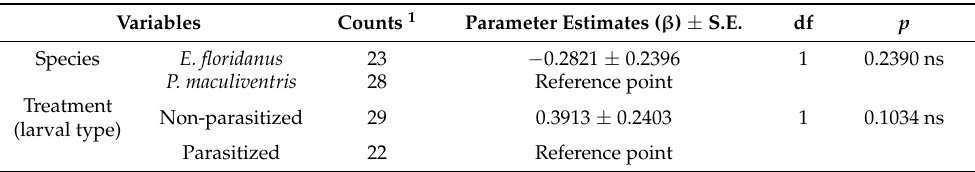
Table 4. Mortality maximum likelihood estimates of fall armyworm larval type (parasitized and non-parasitized) due to predation.